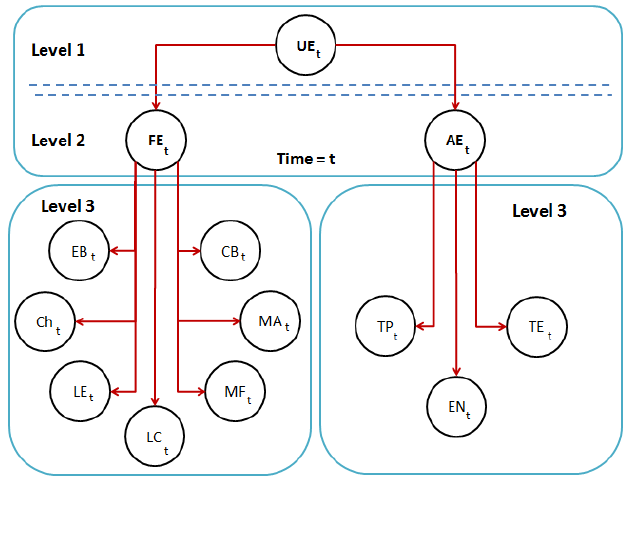
Figure 13. The last dynamic Bayesian network (DBN) classifier combines the estimate of each